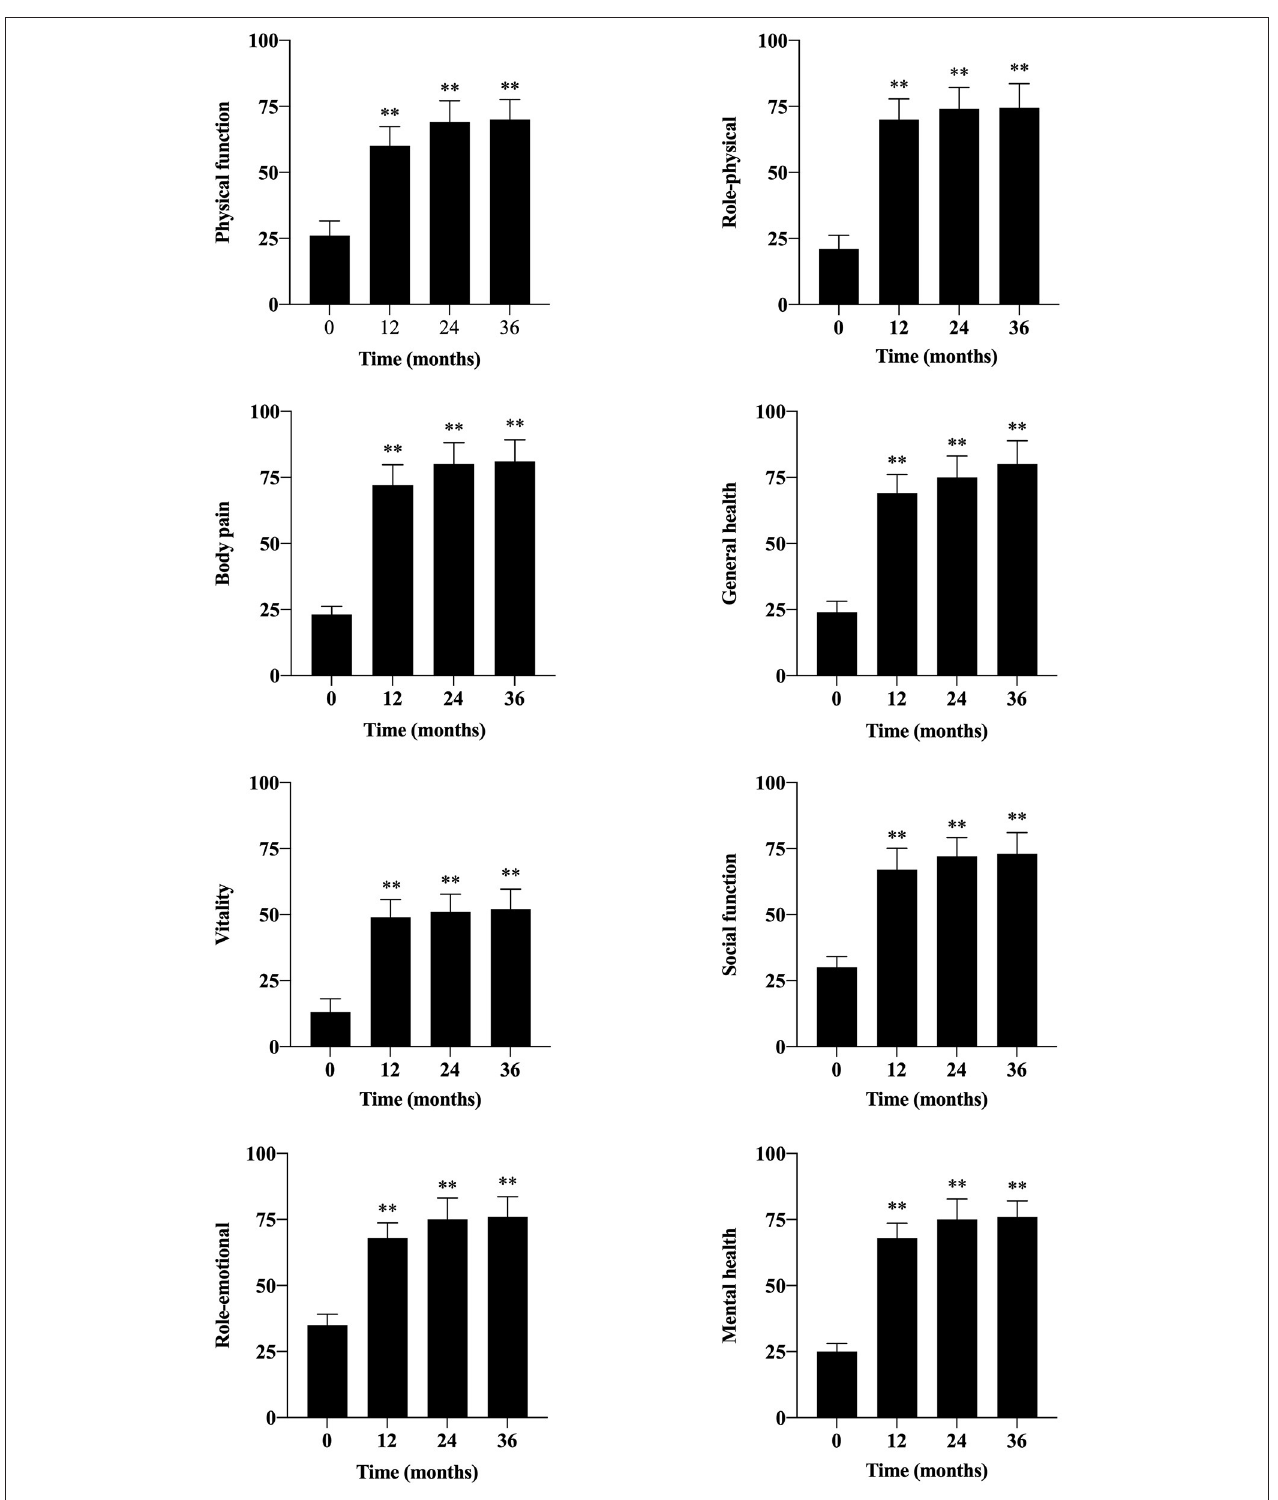
FIGURE 5 | Evaluation of quality of life by SF-36v2 during the follow-up period. The SF-36v2 included eight aspects: physical function, role-physical, body pain, general health, vitality, social function, role-emotional, and mental health. (**, P < 0.01).